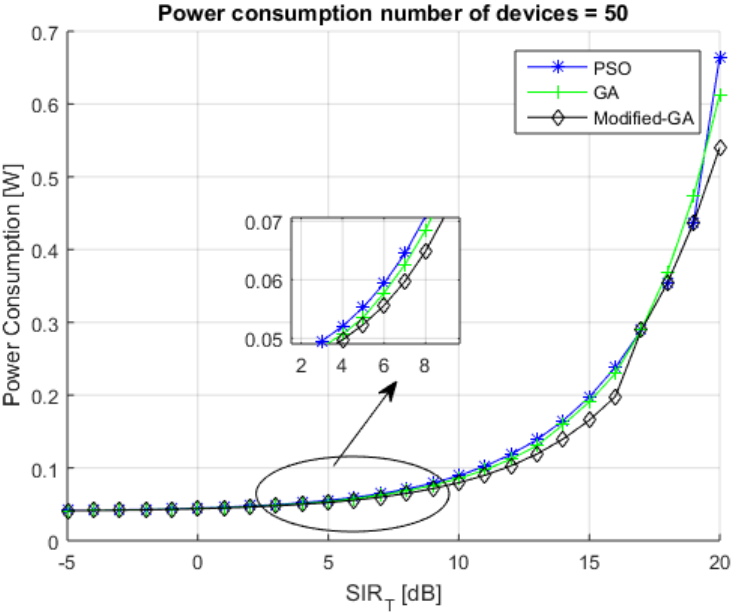
Figure 11. Power consumption vs. the SIR T for different Power optimization